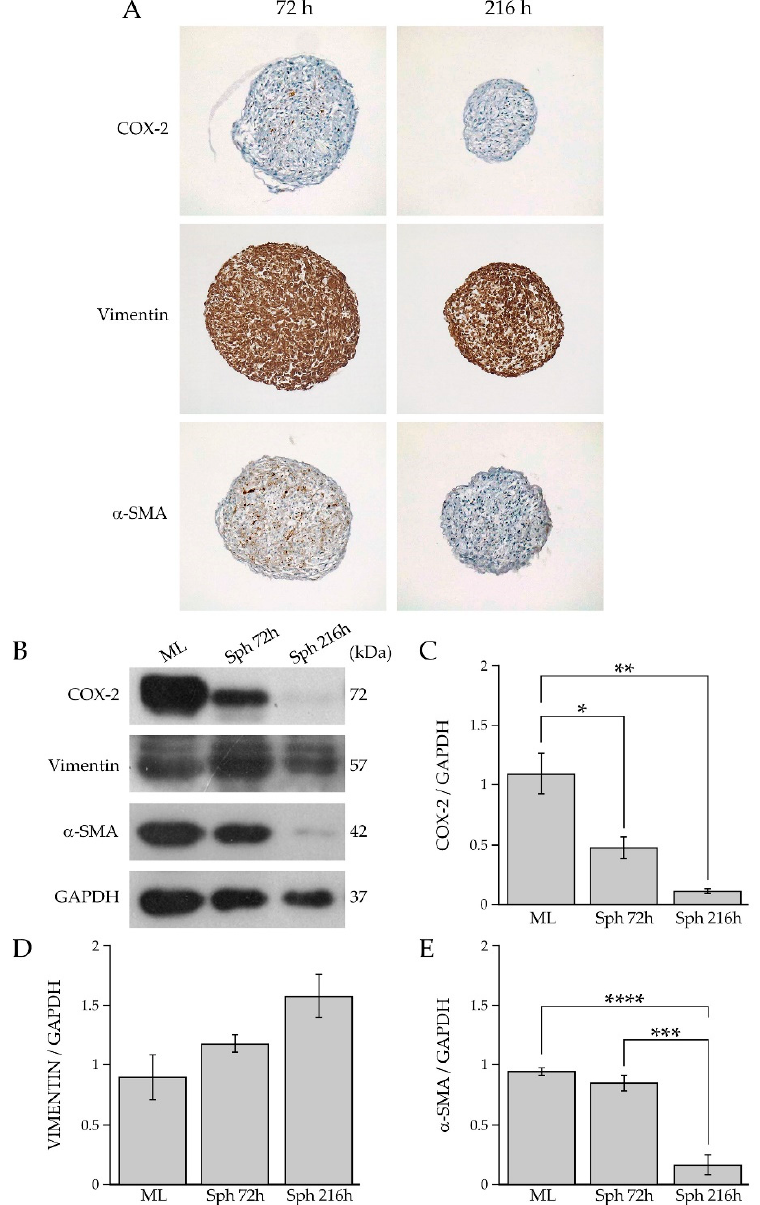
Figure 5. ( A ) Immunohistochemical analysis of COX-2, vimentin and α -SMA in BCAF spheroids collected at 72 h and 26 h. Magnification × 10. ( B ) Western blotting analysis of COX-2, vimentin, and α -SMA in protein extracts of BCAF monolayers (ML) and BCAF spheroids collected at 72 h (SPH 72 h) and 216 h (SPH 216 h) of 3D cell culture on agar. GAPDH was used as the loading control. Representative images of three independent experiments are shown. Densitometric analyses of ( C ) COX-2, ( D ) vimentin and ( E ) α -SMA protein levels. Data are reported as means of three independent experiments ± S.E. * p < 0.05, ** p < 0.005, *** p < 0.001, **** p <